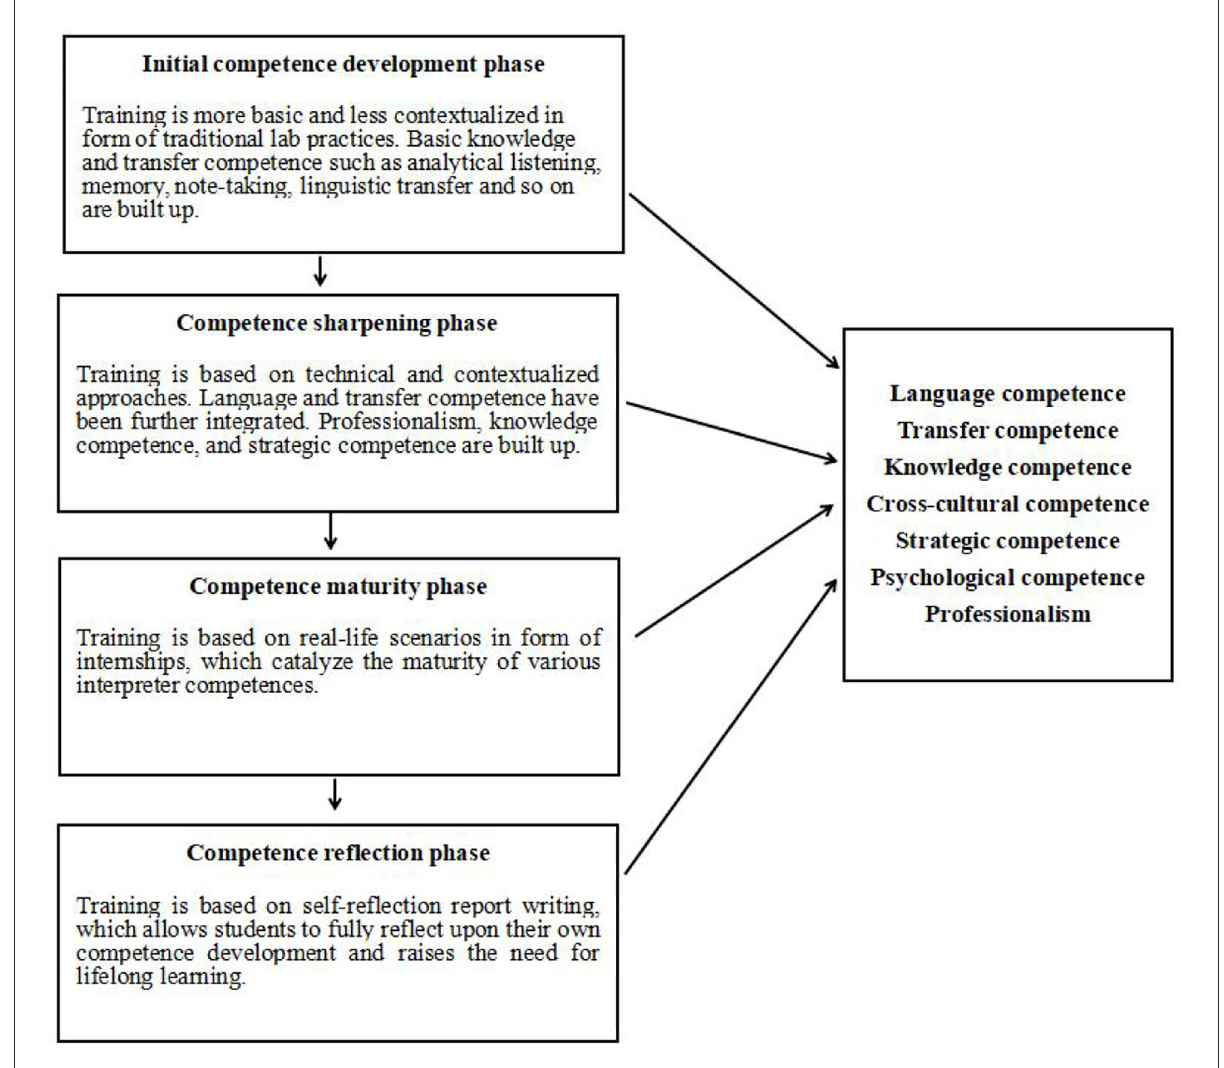
FIGURE1 Four phases of the competence-based interpreting curriculum in